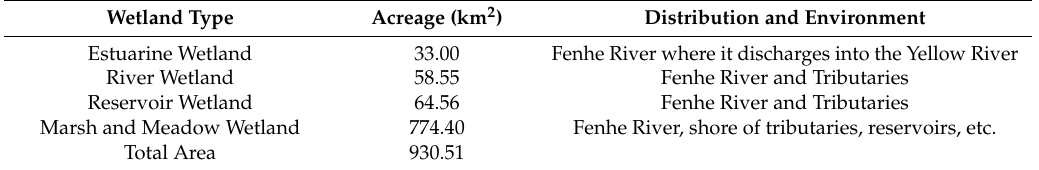
Table 10. Types, distribution, and main characteristics of wetlands in the Fenhe River basin.